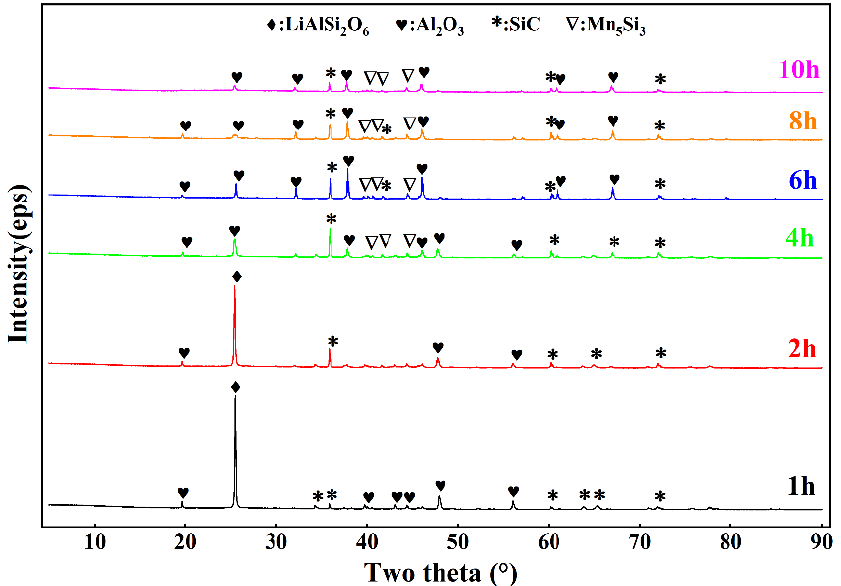
Figure 10. XRD patterns of the upper and middle slag in the reduction residue with varying holding times.